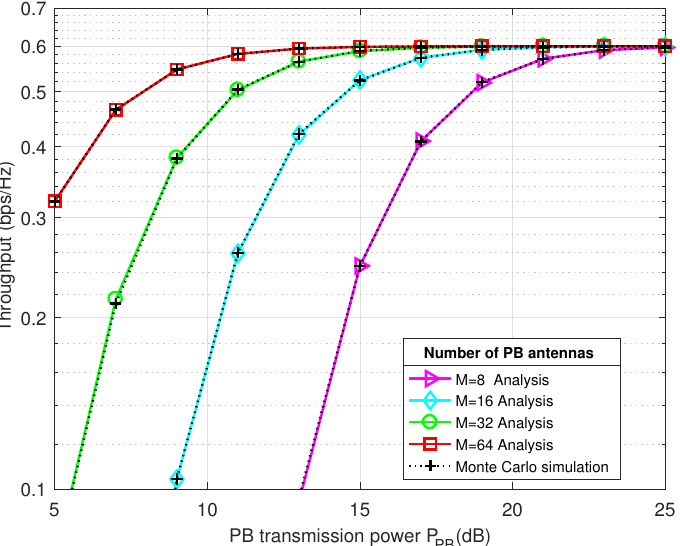
Figure 4. The system throughput performance of the proposed 2-RRS scheme versus the Power Beacon transmitted power P PB (dB) for different PB antennas number M = { 8, 16, 32, 64 } .